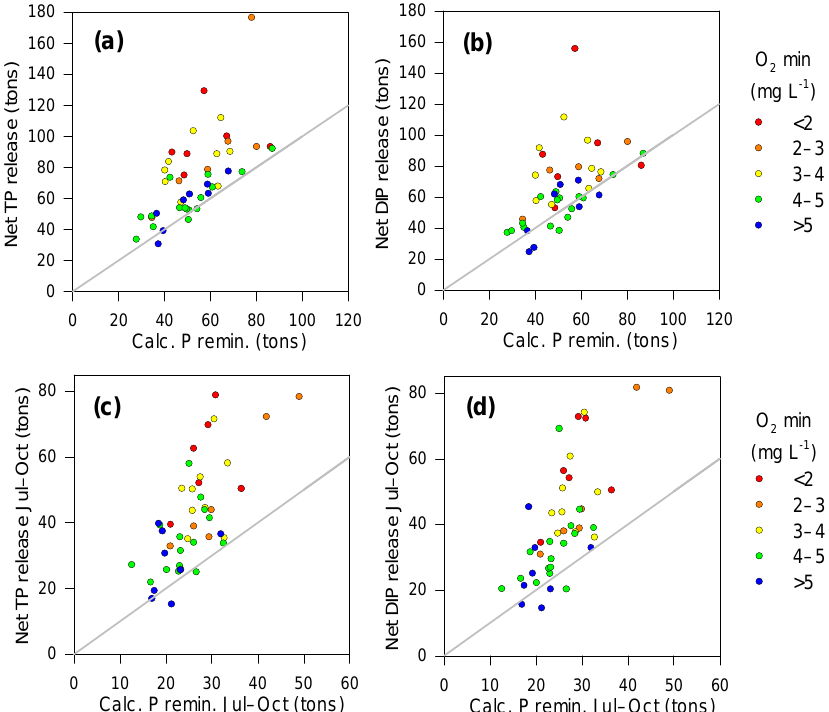
Figure 9. Deep-water ( > 20m) net total phosphorus (TP, a , c ) and dissolved inorganic phosphorus (DIP, b , d ) release in tyr − 1 versus expected P remineralization (calculated from oxygen consumption) for full years (a, b) or July–October (c, d) 1969–2015 (1975 and 2011 excluded). The 1:1 line is shown for comparison. The data set is colour-coded according to the minimum oxygen (O 2 ) concentration for July–October. Linear regressions were all significant (not shown in graphs), (a) y = 8 . 18 + 1 . 19 x , r 2 = 0.42, p < 0.0001 for all values, y = 11 . 1 + 0 . 91 x , r 2 = 0.73, p < 0.0001 for O 2 minimums > 4; (b) y = 4 . 79 + 1 . 17 x , r 2 = 0.30, p < 0.0001 for all values, y = 7 . 71 + 0 . 88 x ,